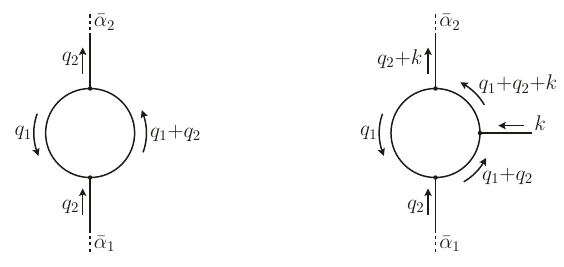
Figure 1 . One-loop subtopologies that can give rise to non-logarithmic UV